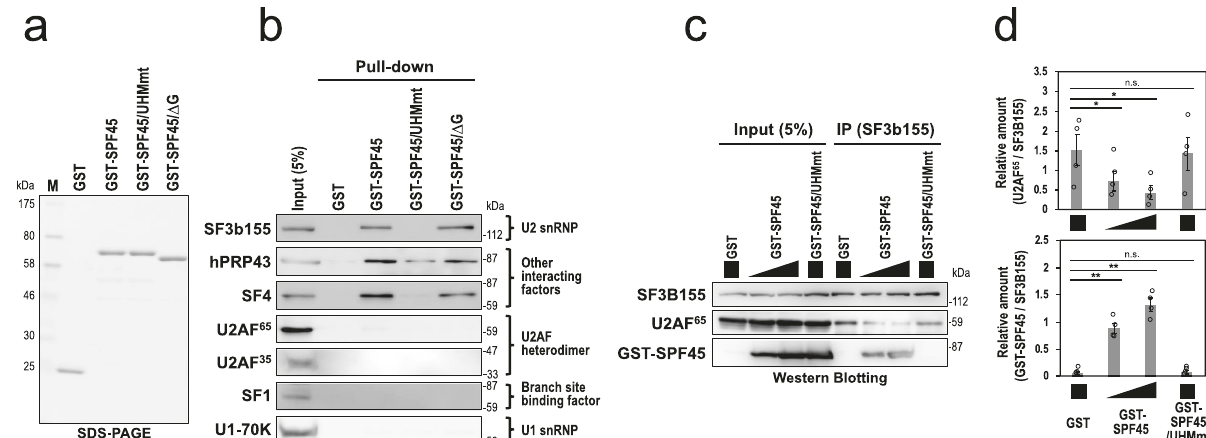
Fig. 7 ULM – UHM binding between SF3b155 and SPF45 promotes splicing of pre-mRNA with short introns. a SDS-PAGE analysis of the indicated puri fi ed recombinant proteins. b GST pull-down assay in RNase A-treated HeLa nuclear extract shows the UHM-dependent binding of GST-SPF45 to SF3b155 but not to U2AF heterodimer. Proteins that associated with these GST-fusion proteins were detected by Western blotting using the indicated antibodies. c Immunoprecipitation of SF3b155 with the indicated GST-fusion proteins shows the competitive binding between U2AF 65 and SPF45 to SF3b155 via UHM – ULM interactions. The same reaction mixtures in panel a were immunoprecipitated with anti-SF3b155 antibody and the associated proteins were analyzed by Western blotting with antibodies against SF3b155, U2AF 65 , and SPF45. d The graph shows quanti fi cation of the bands on Western blots (panel b as the representative blots). U2AF 65 and GST-SPF45 scanned data were normalized to SF3B155 (U2AF 65 /SF3B155 and GST- SPF45/SF3B155) and plotted. Means ± SEM are given for four independent experiments and two-tailed Student t -test values were calculated (Upper panel: p = 0.0470 for GST vs GST-SPF45 left, p = 0.0322 for GST vs GST-SPF45 right, p = 0.6238 for GST vs GST-SPF45/UHMmt; Lower panel: p = 0.0036 for GST vs GST-SPF45 left, p = 0.0010 for GST vs GST-SPF45 right, p = 0.5023 for GST vs GST-SPF45/UHMmt). * P < 0.05, ** P < 0.01, n.s. P > 0.05. Source data of all the above panels are provided as a Source Data fi